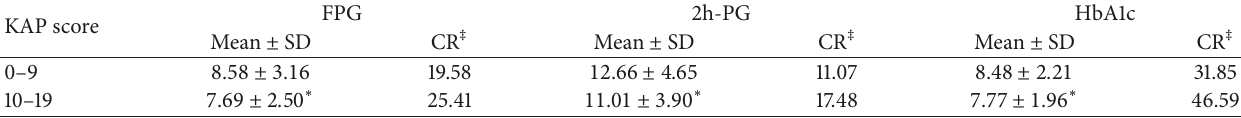
Table 3: Comparison of FBG, 2h-PG, and HbA1c between KAP score